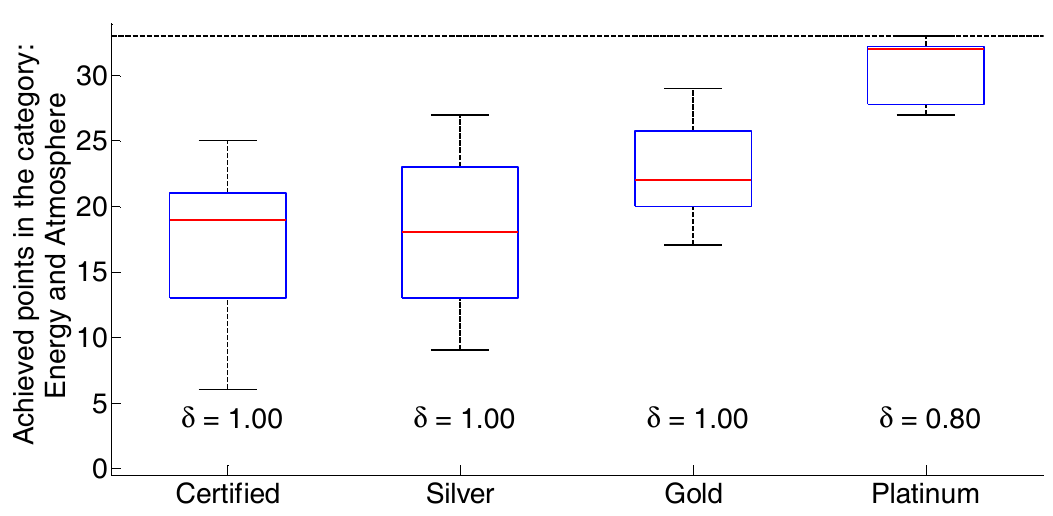
Table 4. Credit points achieved for Water Efficiency category of LEED-NCv4 projects: median ± IQR (25th–75th) and Cliff’s δ effect size between possible and achieved points in a credit.